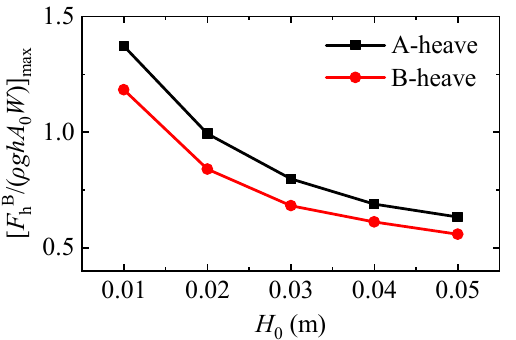
Figure 8. Variations of the normalized largest horizontal wave forces on Box B, [ F h B /( ρ ghA 0 W )] max , against the incident wave height for both structure systems.